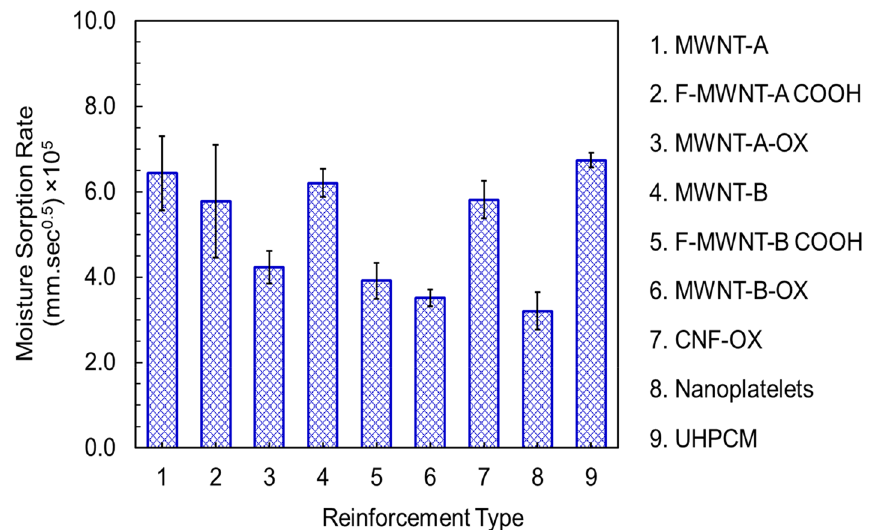
Fig. 9 Moisture sorption rate for UHPCM reinforced with carbon-based nanomateri- als at 0.03 wt.%. Error bars shown are standard deviations determined from 6 replicate